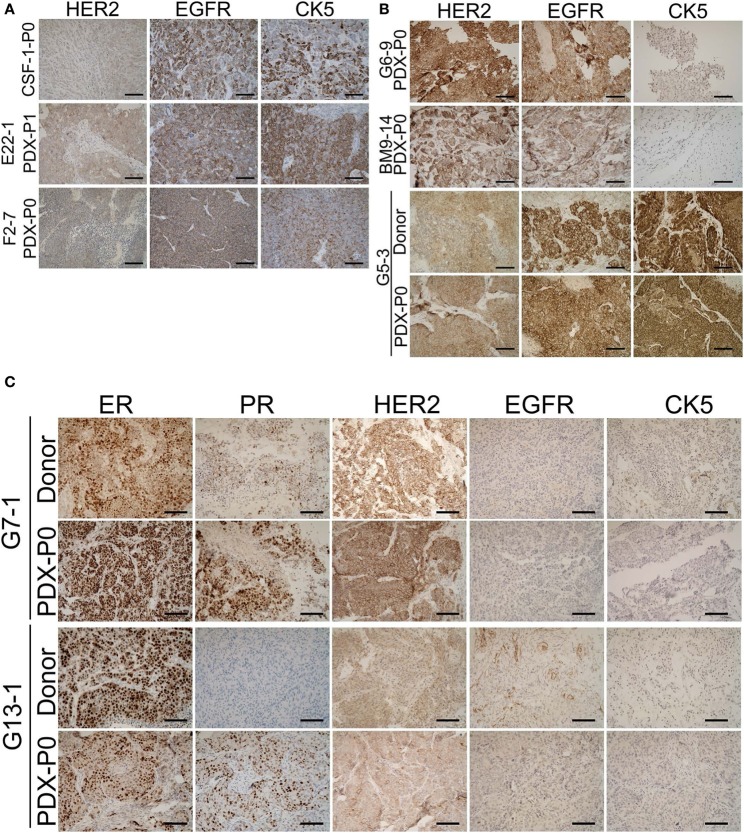
Retention of estrogen receptor (ER), progesterone receptor (PR), HER2, epidermal growth factor receptor (EGFR), and cytokeratin (CK) expression in brain-metastases-patient-derived xenografts (BM-PDXs). Sections of BM-PDXs were stained by IHC for ER, PR, HER2, EGFR, and CK5 at first passage (P0) and compared to donor tumor (when available). (A) Expression of EGFR, HER2, and CK5 in triple negative (TN) BM-PDXs (ER, PR, negative, not shown). (B) Expression of HER2, EGFR, and CK5 in HER2+BM-PDXs in donor and BM-PDXs P0. (C) Expression of ER, PR, HER2, EGFR, and CK5 in ER+HER2+BM-PDXs and their donor counterparts. Scale bars, 100 μm.